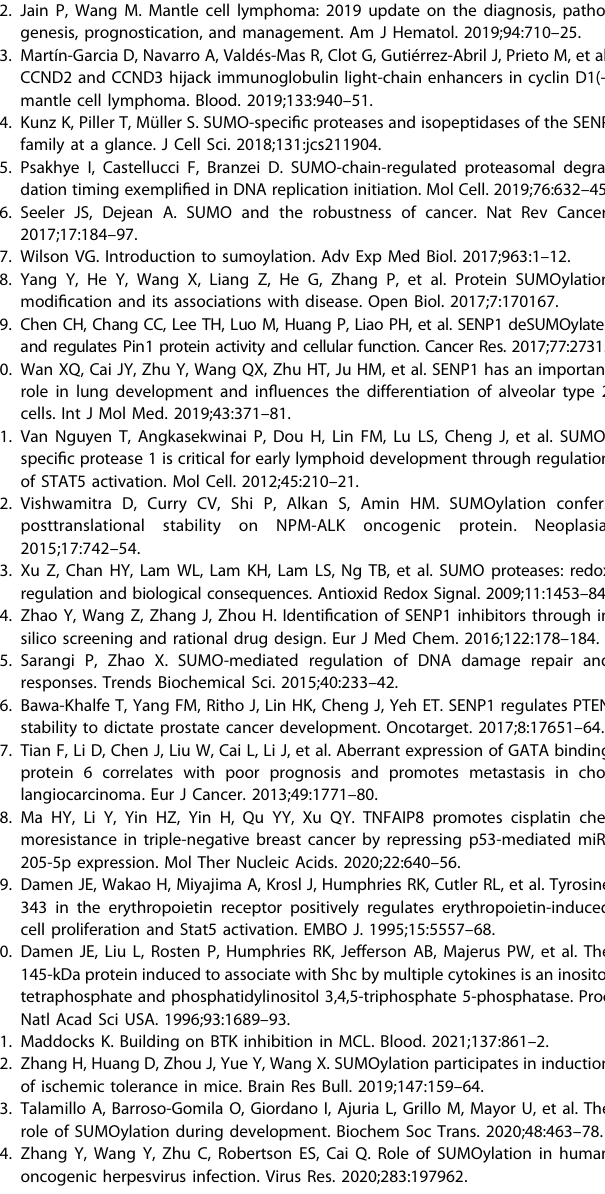
Fig. 6 SENP1 knockdown suppresses MCL growth in vivo. A Images of the MCL xenografts in each mouse subcutaneously injected with shCon or shSENP1-3 transfected Jeko-1 cells ( n = 5 per group). B Tumor volume in shCon and shSENP1-3 groups was recorded every two days for total 17 days. C Tumor growth rate was compared between shCon and shSENP1-3 groups. D Tumor weight was compared between shCon and shSENP1 groups. E Representative immunohistochemical images of SENP1 staining in MCL xenografts from shCon and shSENP1-3 groups. F The mean integrated optical density (IOD) of SENP1 protein in MCL xenografts from shCon and shSENP1-3 groups was calculated by Image- Pro Plus 6.0 software. G SENP1 protein level in each MCL xenograft from shCon and shSENP1-3 groups was measured by western blot. H Representative images of Ki67 staining, TUNEL assay and p-STAT5 in MCL xenografts from shCon and shSENP1-3 groups. I The mean integrated optical density (IOD) of Ki67, TUNEL and p-STAT5 in MCL xenografts from shCon and shSENP1-3 groups were calculated by Image- Pro Plus 6.0 software. Data were presented as mean ± SD and analyzed by two-sided Student ’ s t test. n = 3; * P < 0.05, ** P < 0.01, and *** P <